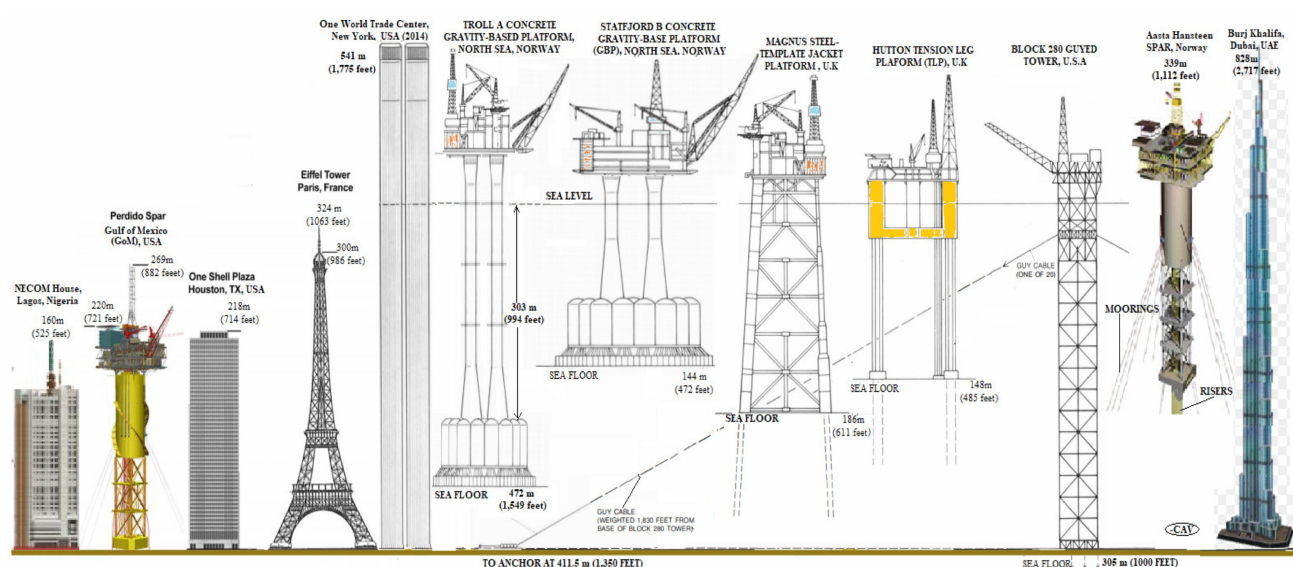
Figure A1. Offshore oil platforms compared to tallest building structures [Credit: Author